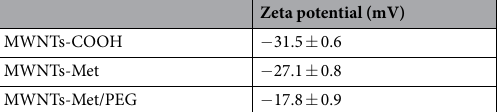
Table 2. Zeta potential ( ζ ) measurement in